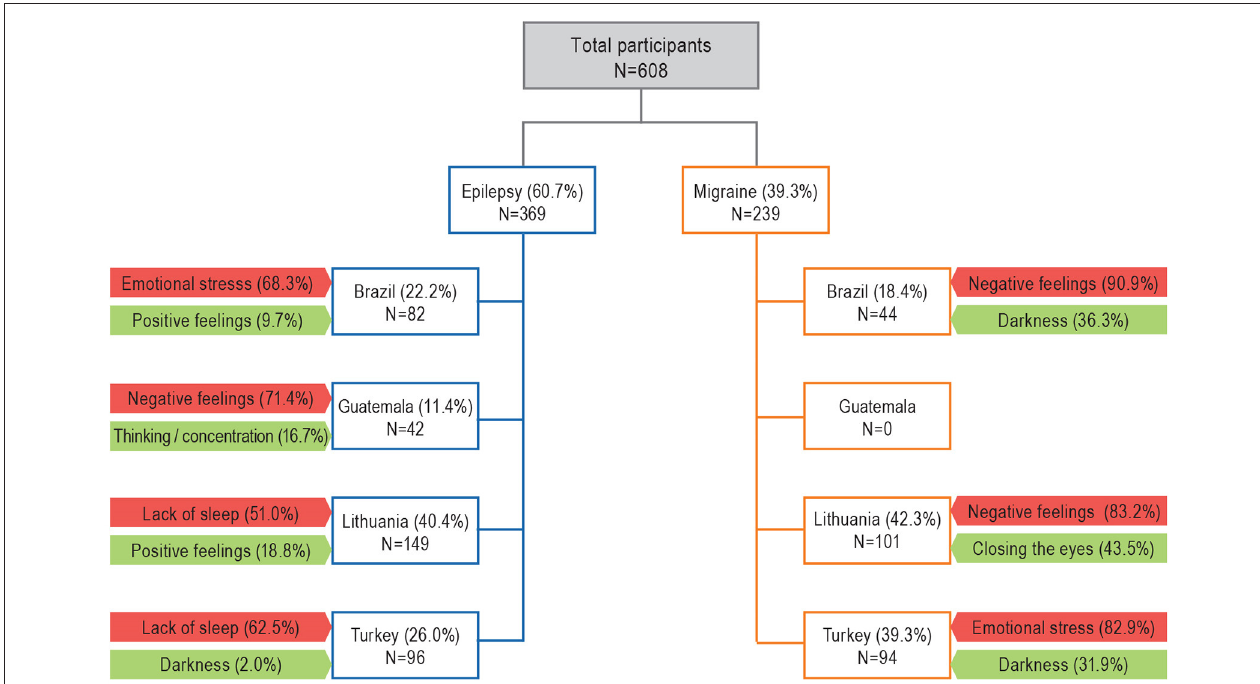
FIGURE 4 | Interviewed patients and most frequently reported modulatory factors according to country. The red-painted boxes show the rate of those reporting “provocations,” whereas the green ones show the rate of reported